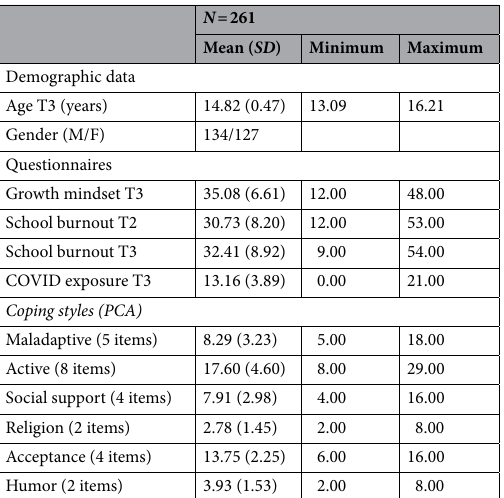
Table 1. Participant characteristics. T2 = pre-pandemic. T3 = during pandemic. M = male. F = female. SD = standard deviation.